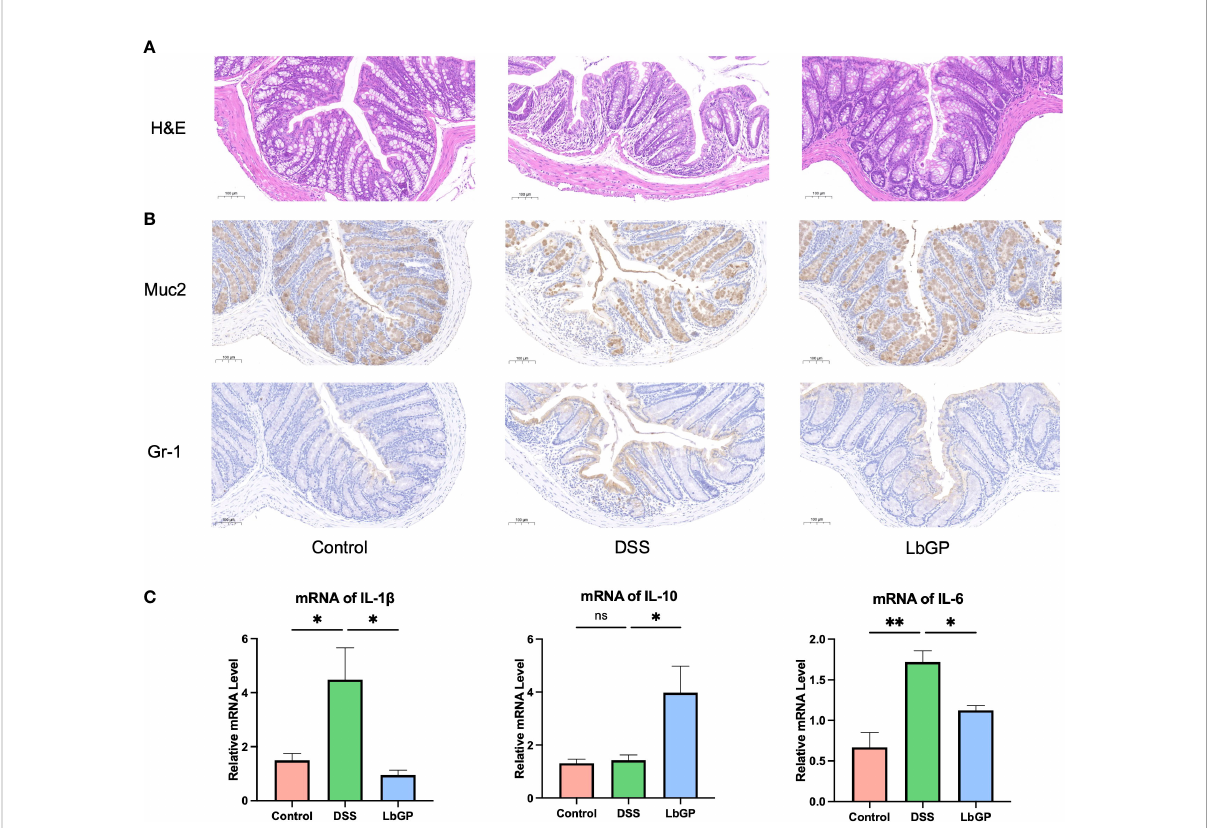
FIGURE 2 LbGP administration reduced in fl ammation during DSS-induced acute colitis. (A) H&E staining at W2. Scale bar, 100 m m. (B) IHC stain of Muc2 and Gr-1 at W2. Representative images are shown. Scale bar, 100 m m. (C) Relative mRNA levels of IL-1 b , IL-10, and IL-6 at W2 (n=3, *P < 0.05, **P < 0.005). “ ns ” means “ no signi fi cant ”